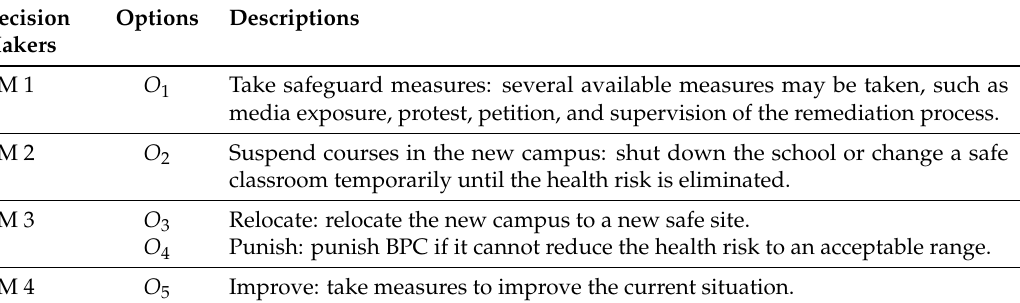
Table 3. Decision makers and their